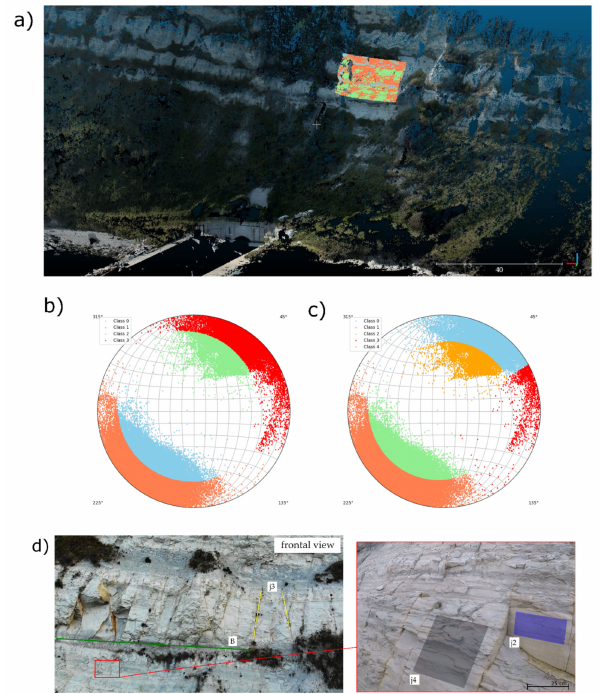
Figure 9. ( a ) Photogrammetry image of the rock cliff with the classified point cloud (represented with colors); ( b ) Stereonet of the unsupervised clustering using K-means with K = 4 derived from the DCS approach; ( c ) results of the semi-supervised clustering in which a specific cluster was re-classified in two clusters; ( d ) overview of the discontinuity clusters identified from the DCS approach with K = 4 (cluster j1 is not clearly visible so is not